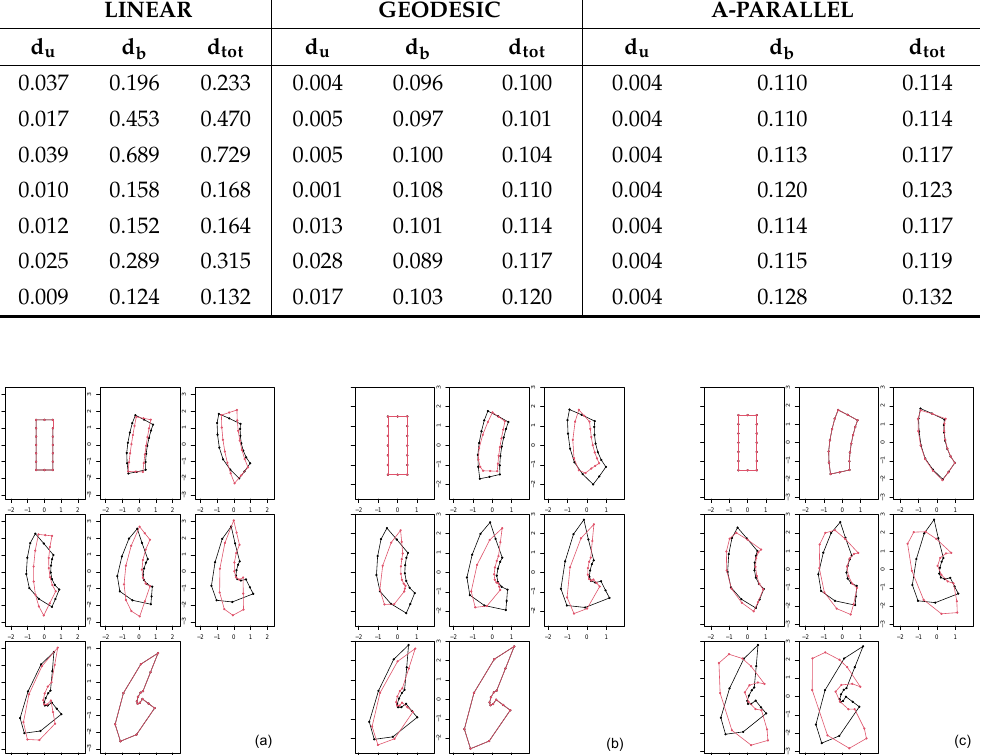
Figure 13. Non-affine case, bending+general affine component, results. ( a ) Left panel: geodesic trajectory shapes (black) plotted against the original parametric shapes (red). ( b ) Center panel: geodesic trajectory shapes (black) plotted against the shapes found via linear interpolation between the first and last shapes of the parametric dataset (red). ( c ) Right panel: geodesic trajectory shapes (black) plotted against autoparallel trajectory (red) built via shooting of the first two configurations of the geodesic.